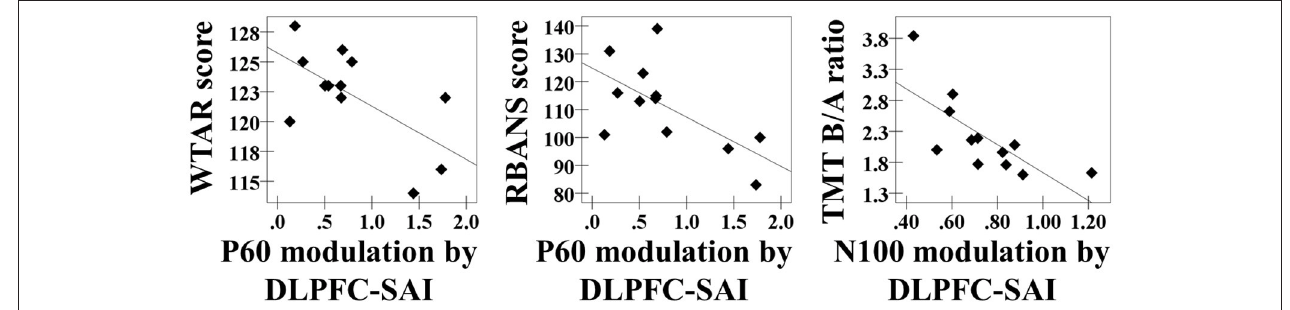
FIGURE 4 | Cognitive correlations. The results of cognitive correlations in the DLPFC–SAI paradigm between WTAR standardized score and the modulation of P60 TEP ( r = − 0.632, p = 0.028, N = 12), between RBANS total scale and the modulation of P60 TEP ( r = − 0.639, p = 0.025, N = 12), and between ratio of TMT part B to TMT part A and the modulation of N100 TEP ( r = − 0.727, p = 0.007, N = 12) at the left frontal